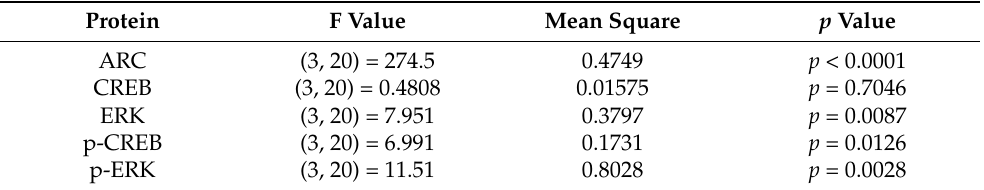
Table 5. Table for ANOVA results for expression levels of proteins 24 h after ketamine injection